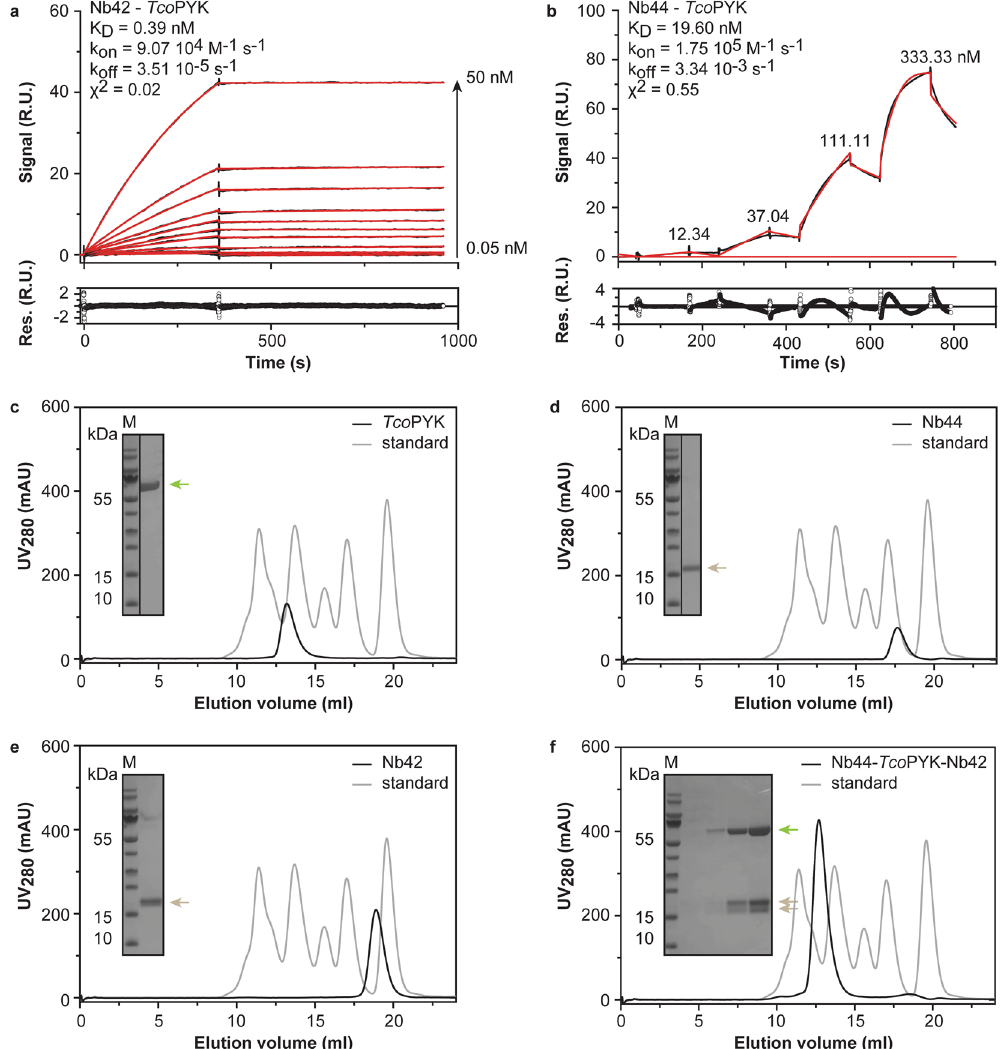
Figure 2. Nb42 and Nb44 recognise distinct epitopes on T . congolense pyruvate kinase. ( a , b ) SPR data recorded for the Nb42- Tco PYK ( a ) and Nb44- Tco PYK ( b ) interactions with the Nbs as ligands and Tco PYK as the analyte. The top panels display the sensorgrams (black traces) and the fit to the data with a 1:1 Langmuir binding model (red traces). The residuals of the fit are shown in the bottom panels. ( c – f ) Investigation of the formation of a tripartite (Nb44) 2 : ( Tco PYK) 4 : (Nb42) 4 complex via analytical SEC: Tco PYK ( c ) Nb44 ( d ) Nb42 ( e ) and Nb42 mixed with the preformed Nb44: Tco PYK complex in the correct stoichiometric amounts ( f ). All experiments were performed on an ENRICH 650 10/30 column. The black and grey traces represent the chromatograms of the different protein samples and the BioRAD gel filtration standard, respectively. In all figures, the inset shows an SDS-PAGE analysis of the elution peaks. Tco PYK (MM = 56.2 kDa), Nb44 (MM = 14.3 kDa), and Nb42 (MM = 16.4 kDa) are indicated by the green and brown arrows, respectively. Lane M, Prestained Protein Molecular Weight Marker (ThermoFischer